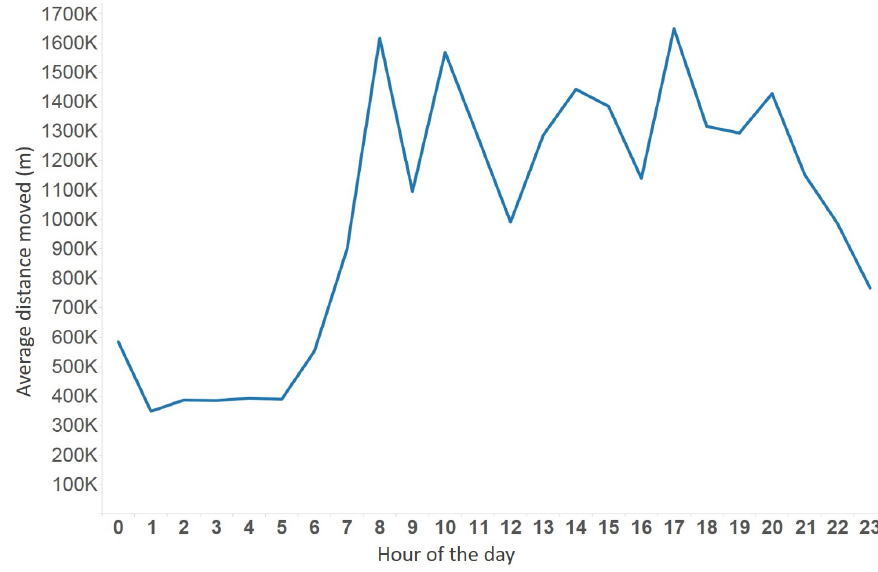
Figure 11. The total distance traveled by all tagged carts in different hours.